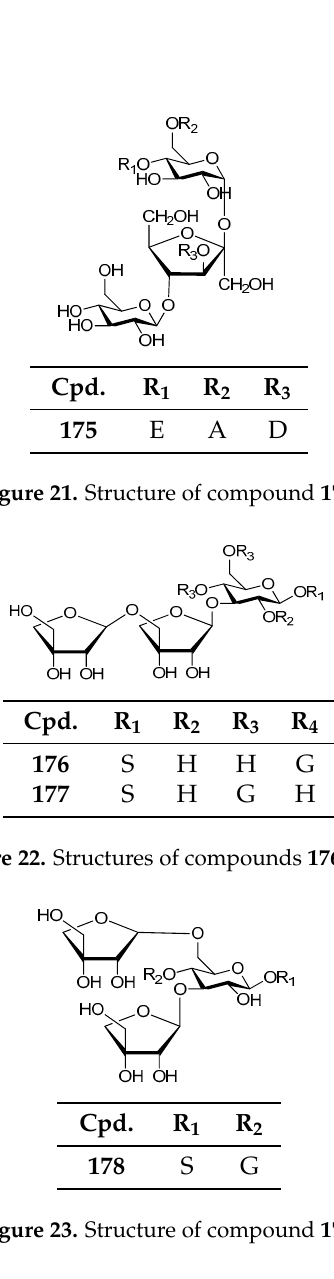
Figure 24. Structures of compounds 179 – 182 .